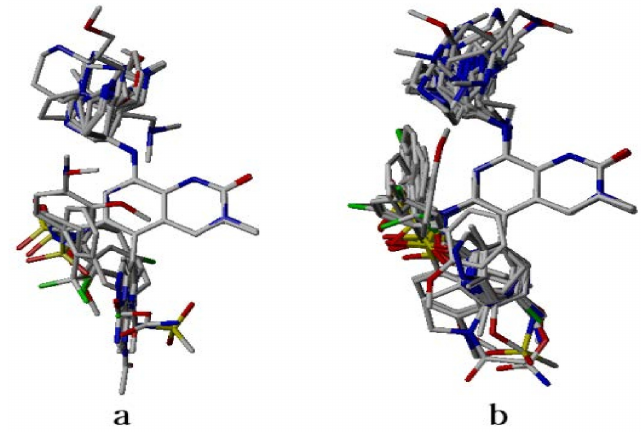
Figure 1. Alignment of dataset compounds ( a ) Ligand-based alignment of the conformers obtained from omega software; ( b ) Structure-based alignment of docked compounds. Table 1. Statistical Results of Structure- and Ligand-Based